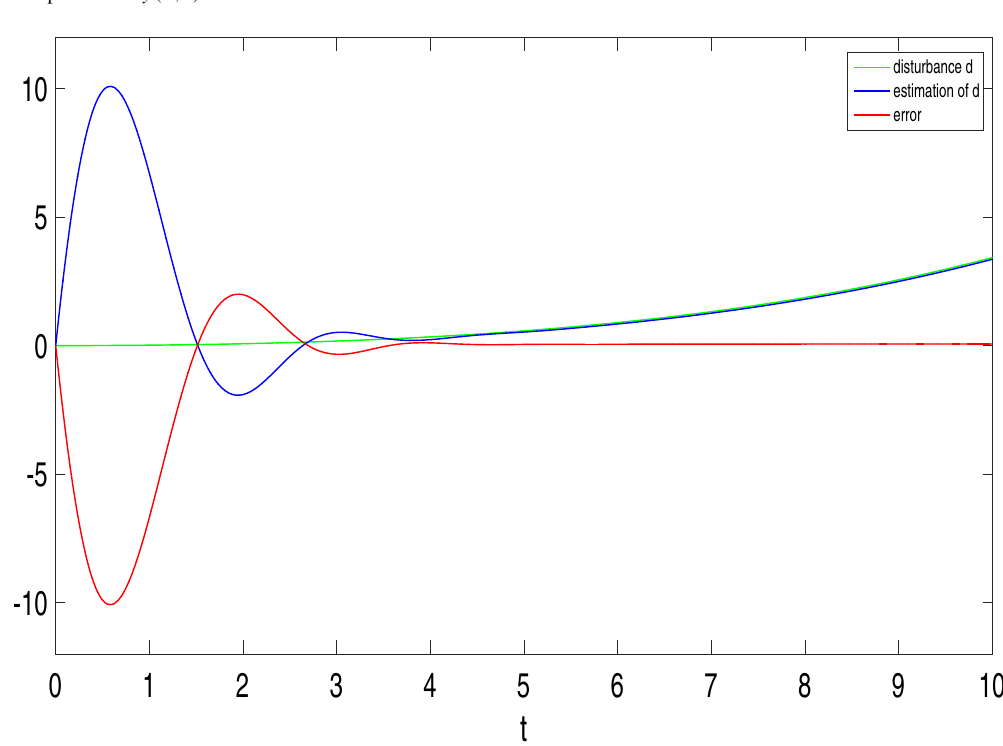
Fig. 3 Displacement y ( x , t ) with control